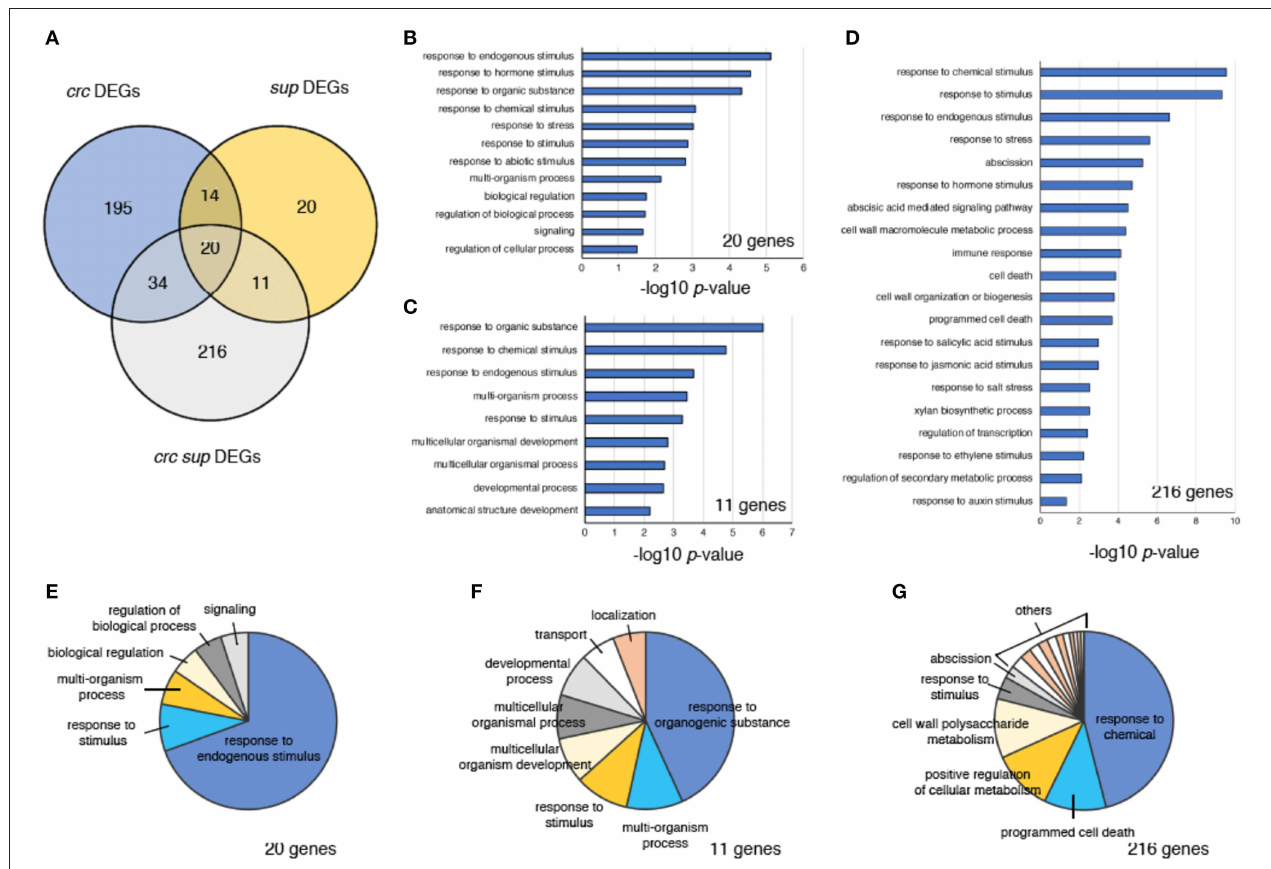
FIGURE 4 | Characterization of DEGs in crc sup . (A) Venn diagram showing the number of DEGs in crc , sup , and crc sup mutants. (B–D) GO term enrichment analysis of categories containing 20 genes (B) , 11 genes (C) , and 216 genes (D) . Selected terms determined by their –log 10 -adjusted p -values are shown. (E–G) Pie charts showing summarized GO terms by REVIGO in categories of 20 genes (E) , 11 genes (F) , and 216 genes (G) within the GO term category “biological process”.